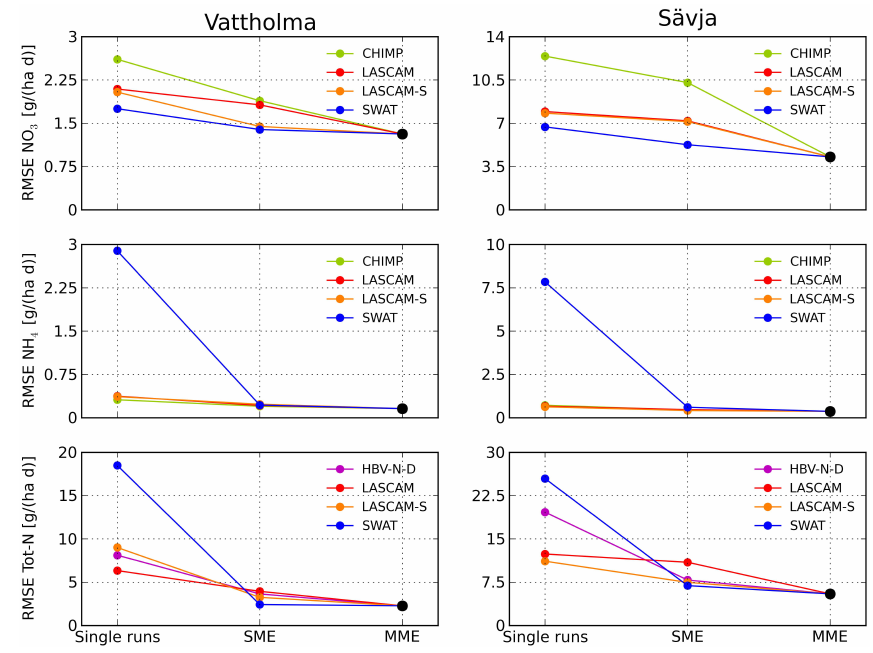
Fig. 4. Evolution of the best RMSE value between single models, SMEs and MMEs (full black circle).